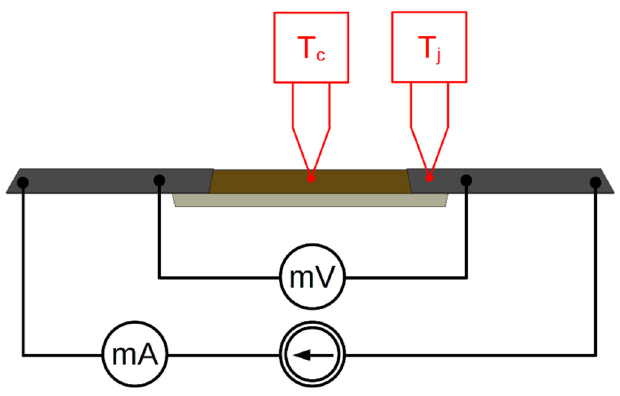
Figure 4. Method of measuring the temperature on the sample surface.